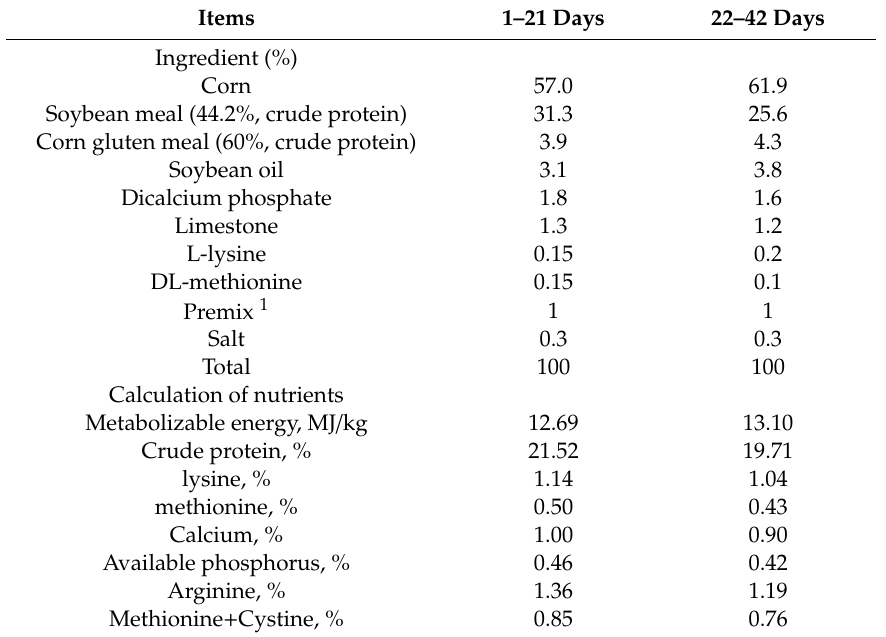
Table 1. Ingredient Composition and Calculated Nutrient Content of the Basal Diets (Experiment 2). Items 1–21 Days Ingredient (%) Corn 57.0 Soybean meal (44.2%, crude protein) Corn gluten meal (60%, crude